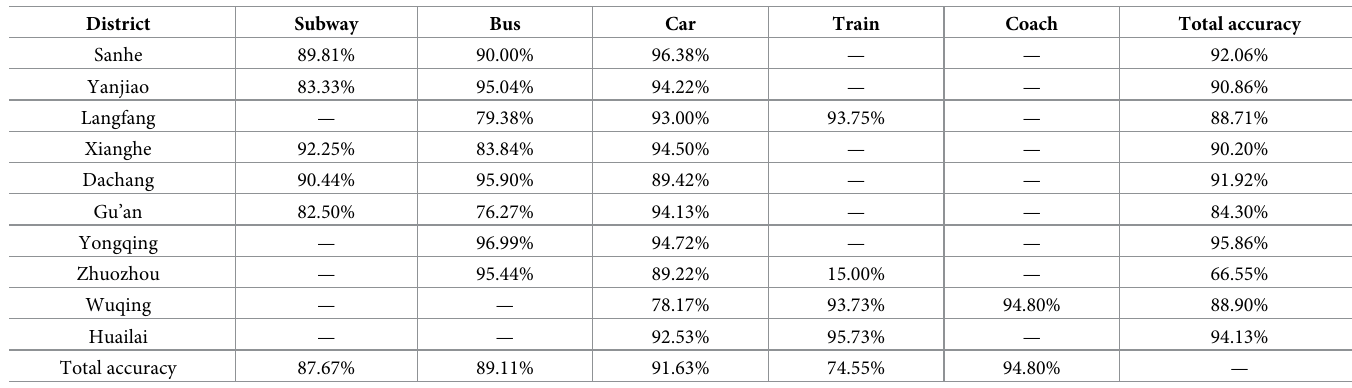
Table 6. SRBM model prediction accuracy of 10